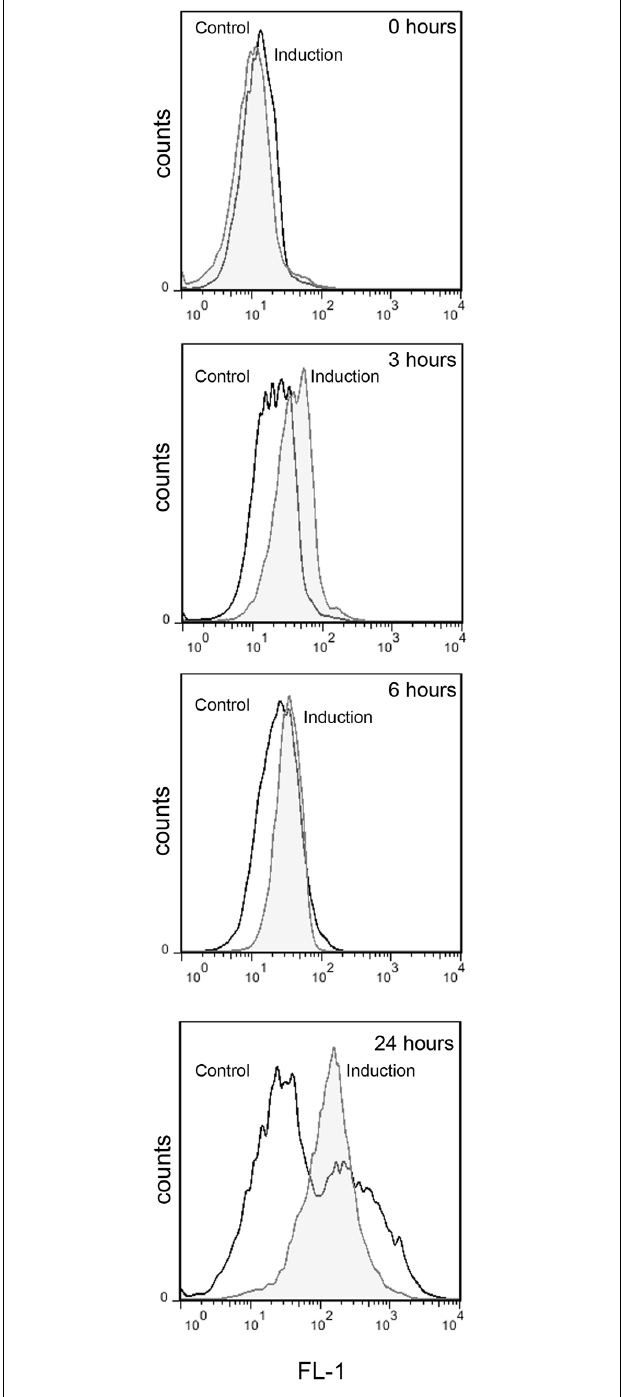
FIGURE 6 | Production of ROS during capsule induction. Cells from H99 strain were grown in Sabouraud overnight then transfer to the same medium (control, black line) or capsule induction medium (induction, gray filled histogram). The production of ROS was evaluated at time 0, 3, 6, and 24 h by flow cytometry as described in Section “Materials and Methods.” As positive control we used samples in the presence of AmB (1 µ g/mL). The graph represents the results of a representative experiment, which was performed three different